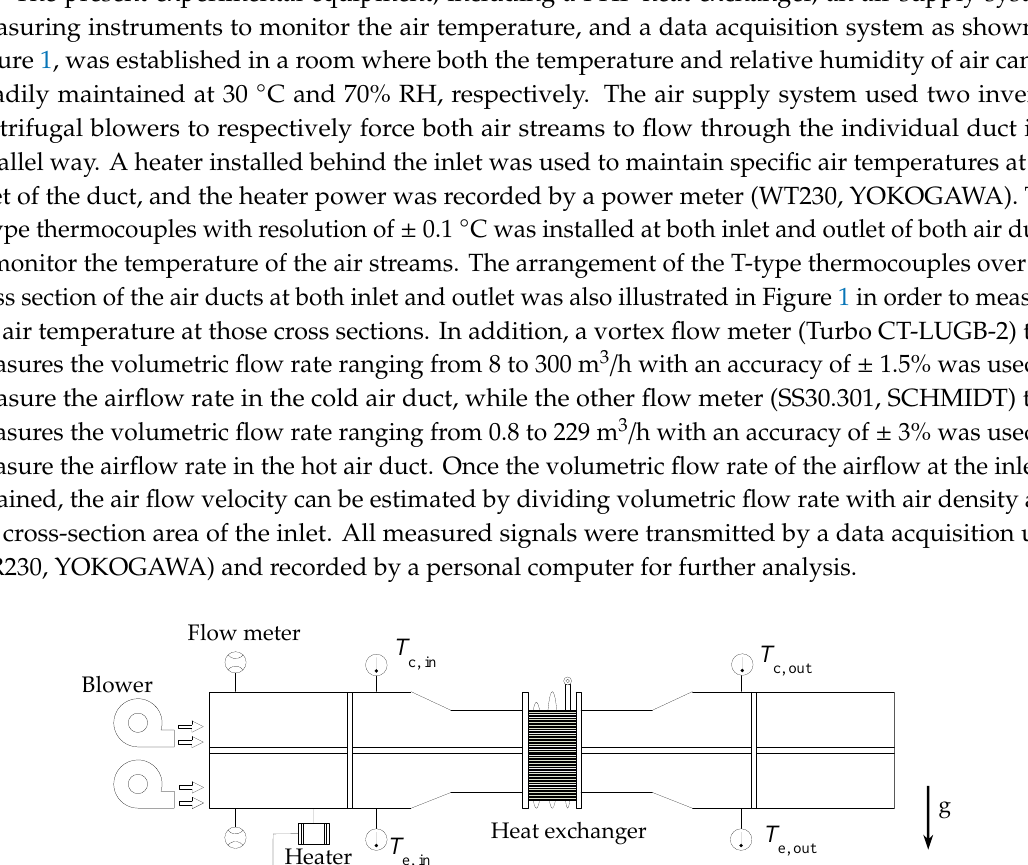
Figure 2. The assembly of the bare tubes and a total of 124 pieces of 0.1 mm thick aluminum alloy plate fin using solder accomplishes a PHP heat exchanger of 132 × 44 × 200 mm in external dimensions. The PHP was vertically embedded in the plate fin array with the evaporating section being held at the bottom. The spacing between two adjacent plate fins was 1.6 mm. In addition, the bare tubes were arranged in three staggered rows whose transverse and longitudinal pitch between the tubes were 18 and 14 mm, respectively, as shown in Figure